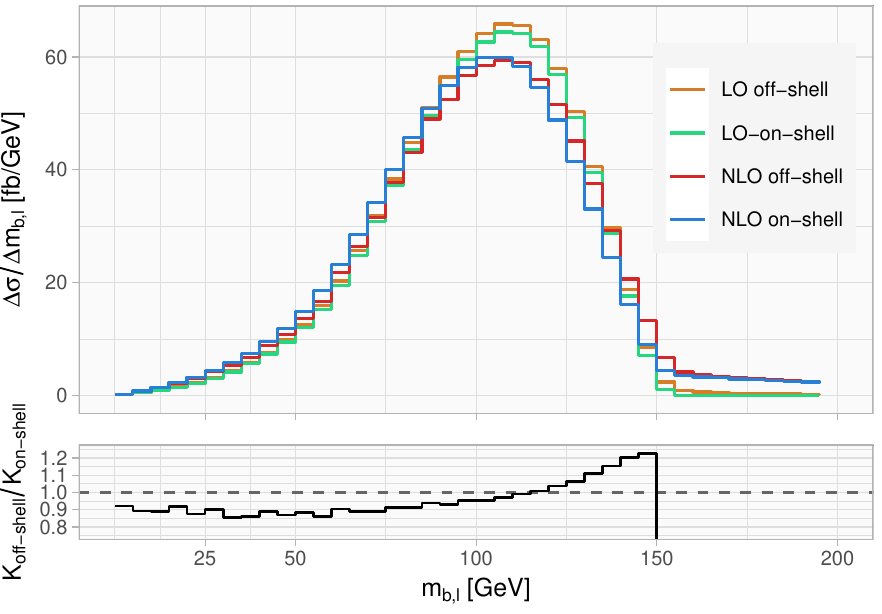
Figure 7. Invariant mass of the positron plus leading b -jet system for the top-quark on-shell approximation and for the o(cid:11)-shell top quark at LO and NLO . The lower panel shows the ratio of the ratio of the NLO / LO K -factors from the o(cid:11)-shell and on-shell results.